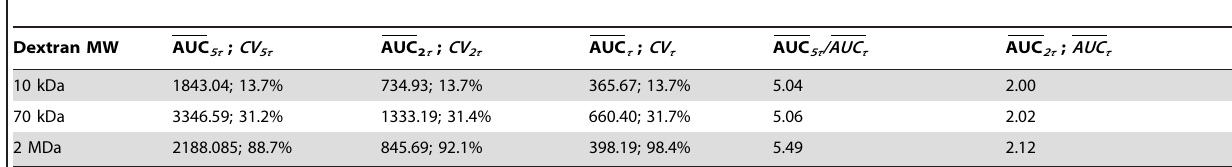
Table 4. The average AUC and CV values corresponding to drug carriers of different half-lives shown in Figure 7.